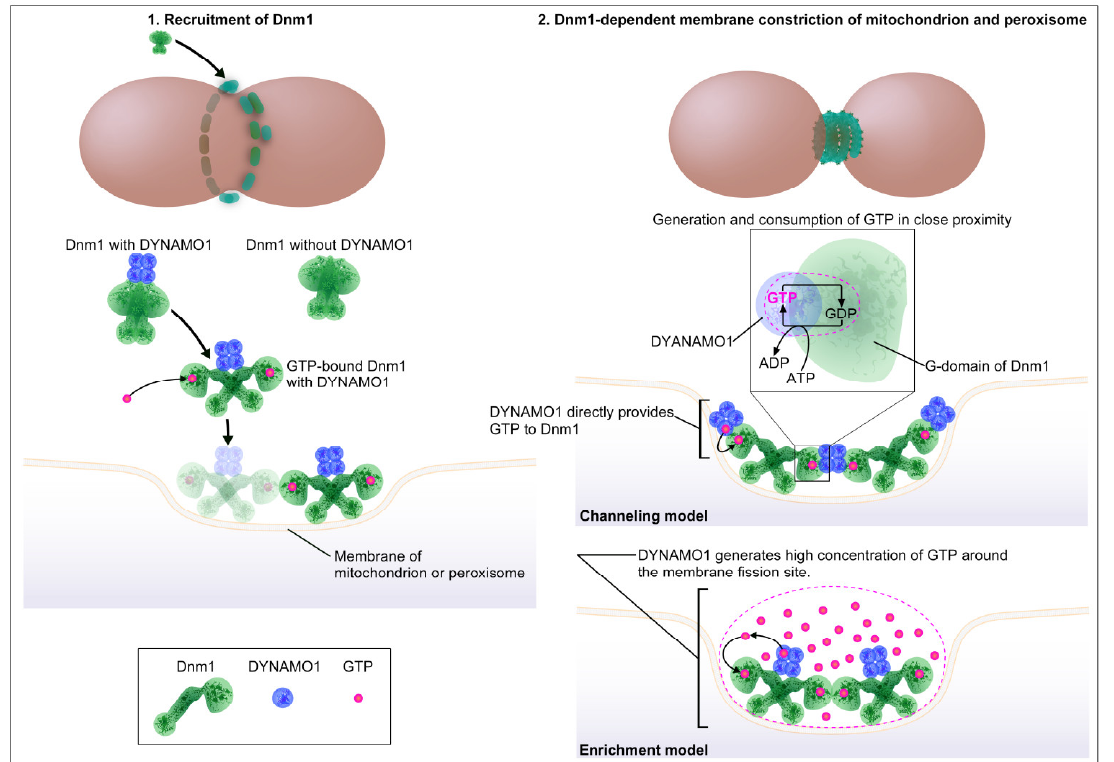
Figure 3. DYNAMO1 locally generates GTP for the GTPase activity of Dnm1 during the division of mitochondrion and peroxisome in C. merolae . During the recruitment of Dnm1 to mitochondrial membrane, DYNAMO1 binds to Dnm1 and promotes the recruitment by enhancing the G-domain function of Dnm1. During the constriction of Dnm1-based membrane fission machinery, DYNAMO1 is thought to provide GTP locally to Dnm1 by mechanisms called a channeling model or an enrichment model. In the channeling model, DYNAMO1 provides GTP in close proximity to G-domain of Dnm1. In the enrichment model, DYNAMO1 elevates local GTP concentration around the membrane fission site.